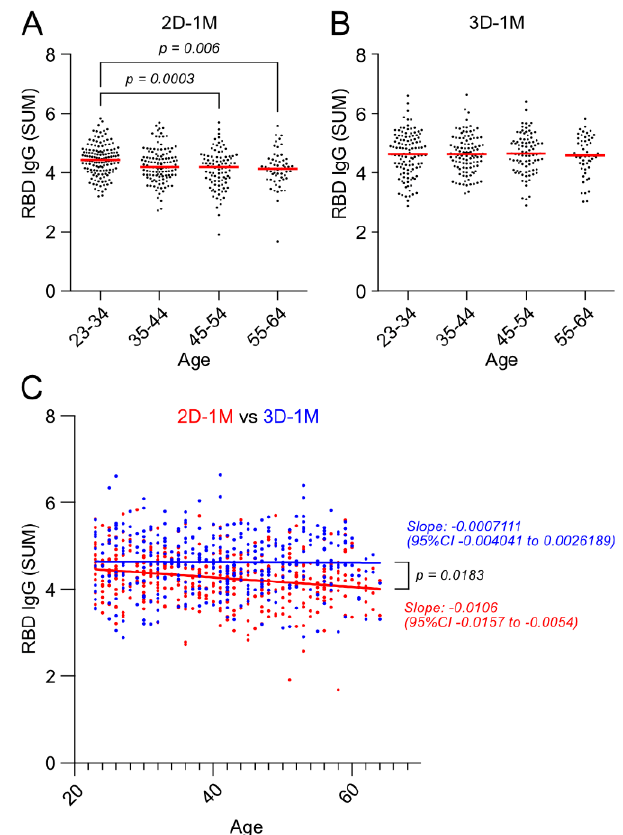
Figure 6. Negative effect of age on anti-RBD IgG responses after the second dose of BNT162b2 was lost after the third dose of BNT162b2 vaccination. Anti-RBD IgG are measured using serial dilutions of serum obtained from participants in an indirect ELISA assay and the sum of ABS450 values of six serial 4-fold dilutions (SUM) is calculated. ( A , B ) Effect of age on anti-RBD IgG responses 1 M after the second (2D-1M) and third (3D-1M) doses of BNT162b2 are analyzed by age groups (in 10-year bins) of the HCW cohort. ( C ) Regression analysis of RBD IgG with age of individuals is shown. RBD IgG titers of individuals obtained at 2D-1M are shown in red and individual RBD-IgG titers at 3D-1M are shown in blue. Linear regression lines obtained from 2D-1M and 3D-1M are statistically significantly different ( p =